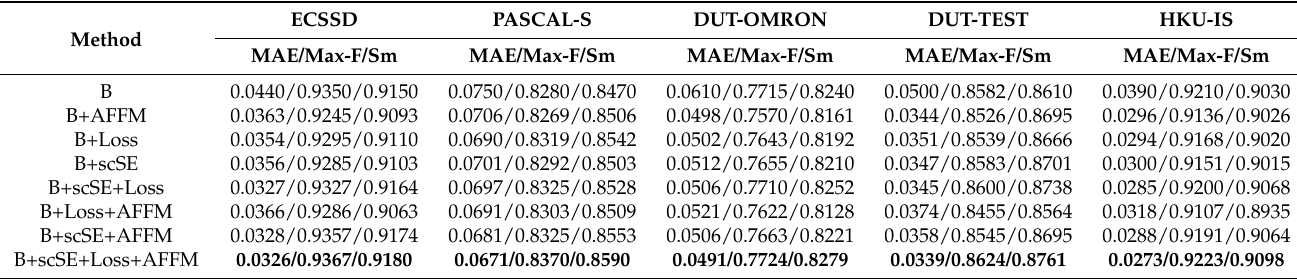
Table 2. Comparison of different combinations of three components. B denotes the baseline. AFFM denotes adaptive feature fusion module. scSE denotes channel-spatial attention. Loss denotes hybrid loss. The best results are in bold.